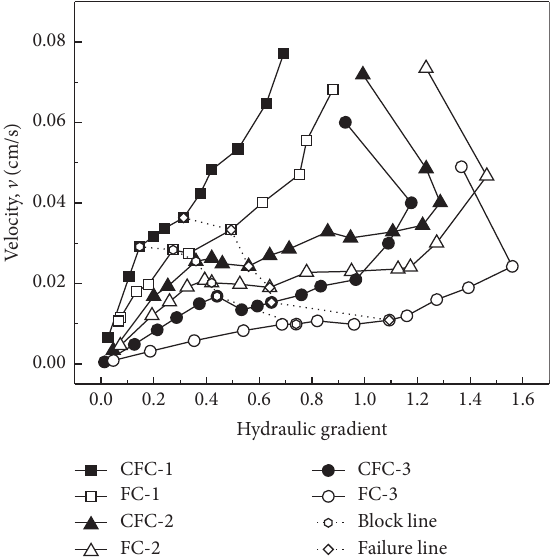
Figure 3: Variation of flow velocity with hydraulic gradient for CFC and FC